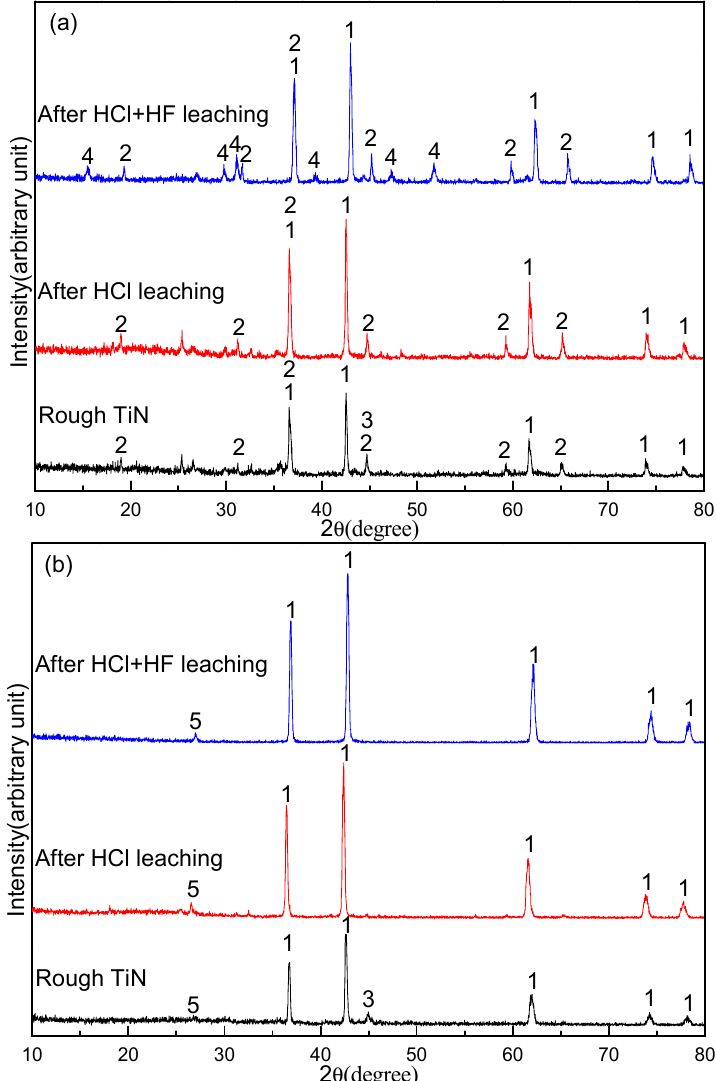
Figure 9. Effect of sodium borate on the acid leaching of impure TiN: XRD of TiN products ( a ) without sodium borate and ( b ) with 16% sodium borate. 1—TiN(PDF#38-1420); 2—MgAl 2 O 4 (PDF21-1153); 3—Fe(PDF#06-0696); 4—CaMg 2 Al 2 F 12 (FDF#25-0152); 5 ‐ C(PDF#26 ‐ 1080).